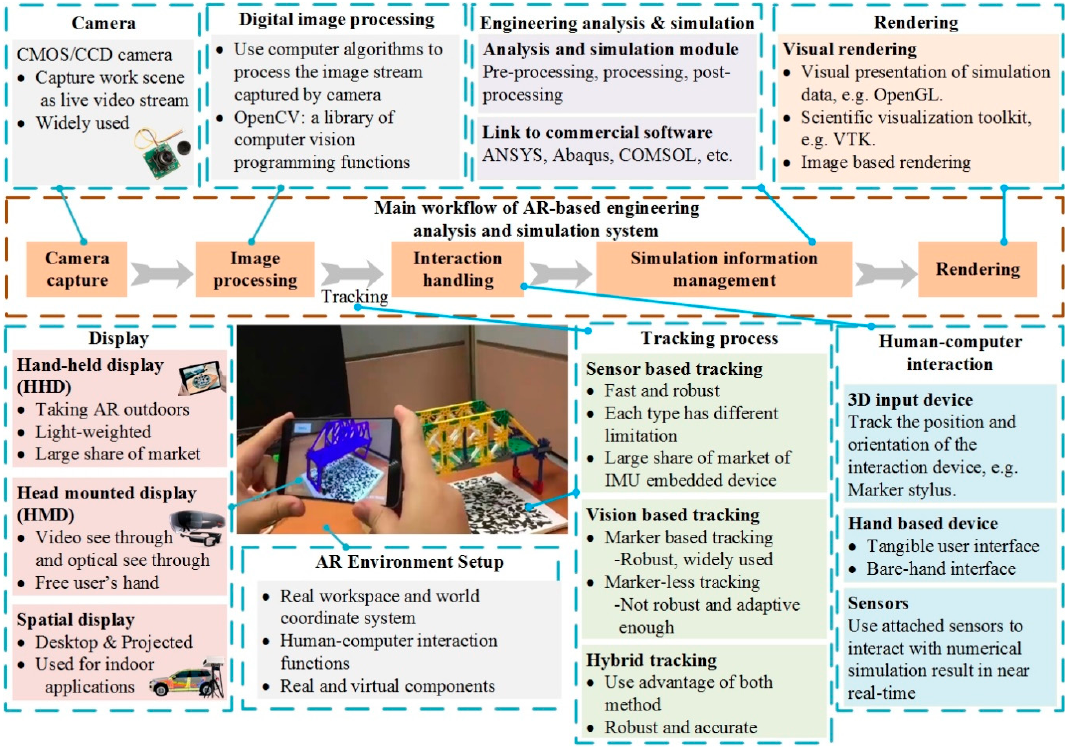
Figure 1. Workflow of AR-based engineering analysis and simulation system.